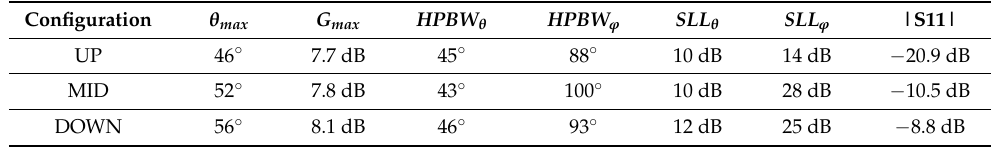
Table 1. Measured parameters of the realized two-row ESPAR